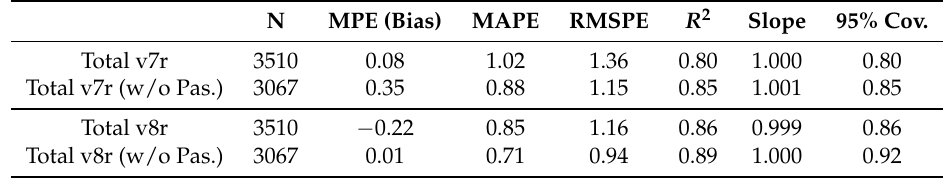
Table 2. Summary statistics of the differences between the fixed rank kriging predictions and the Total Carbon Column Observing Network (TCCON) measurements between 1 October 2014 and 28 February 2017 and across 24 TCCON stations (or 23 without Pasadena – w/o Pas.). Summary statistics include the mean prediction error (MPE), the mean absolute error (MAPE), the root-mean-squared prediction error (RMSPE), the coefficient of determination ( R 2 ), the slope (Slope) of the regression line constrained to pass through ( 0,0 ) and the empirical 95% coverage (95% Cov.). The number of observations considered in each row is denoted as N . N MPE (Bias) MAPE RMSPE R 2 Slope 95% Cov. Total v7r 3510 0.08 1.02 1.36 0.80 1.000 0.80 Total v7r (w/o